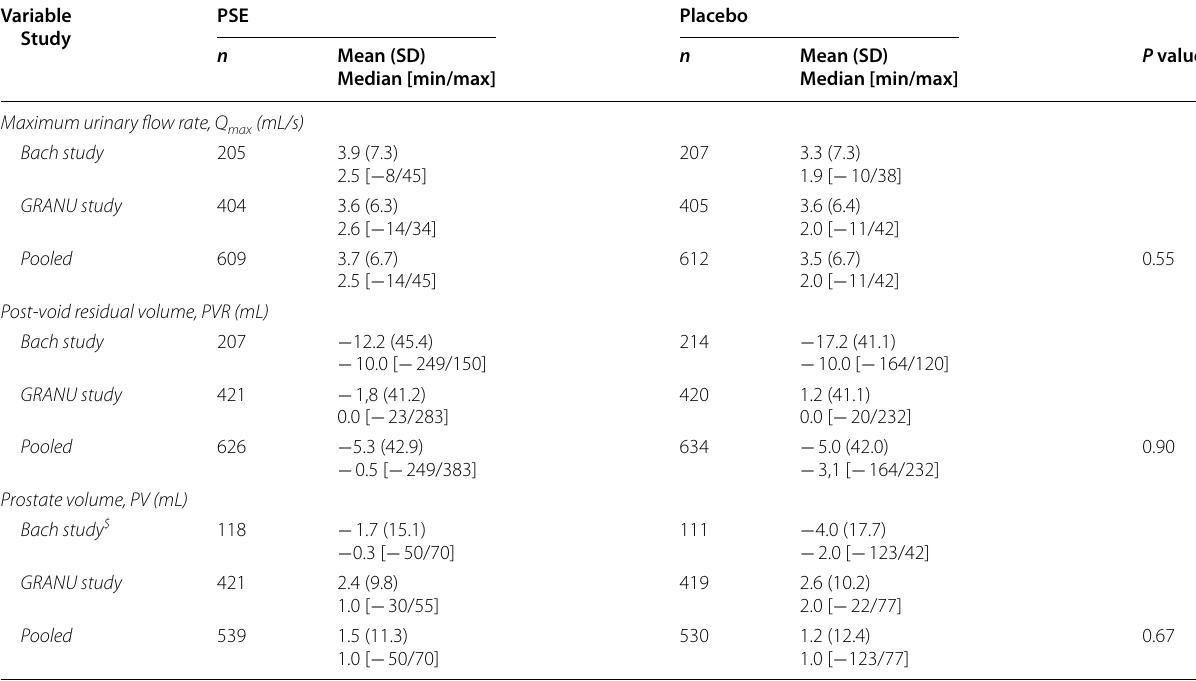
a Prostate volume measurement was optional. PSE pumpkin seed soft extract